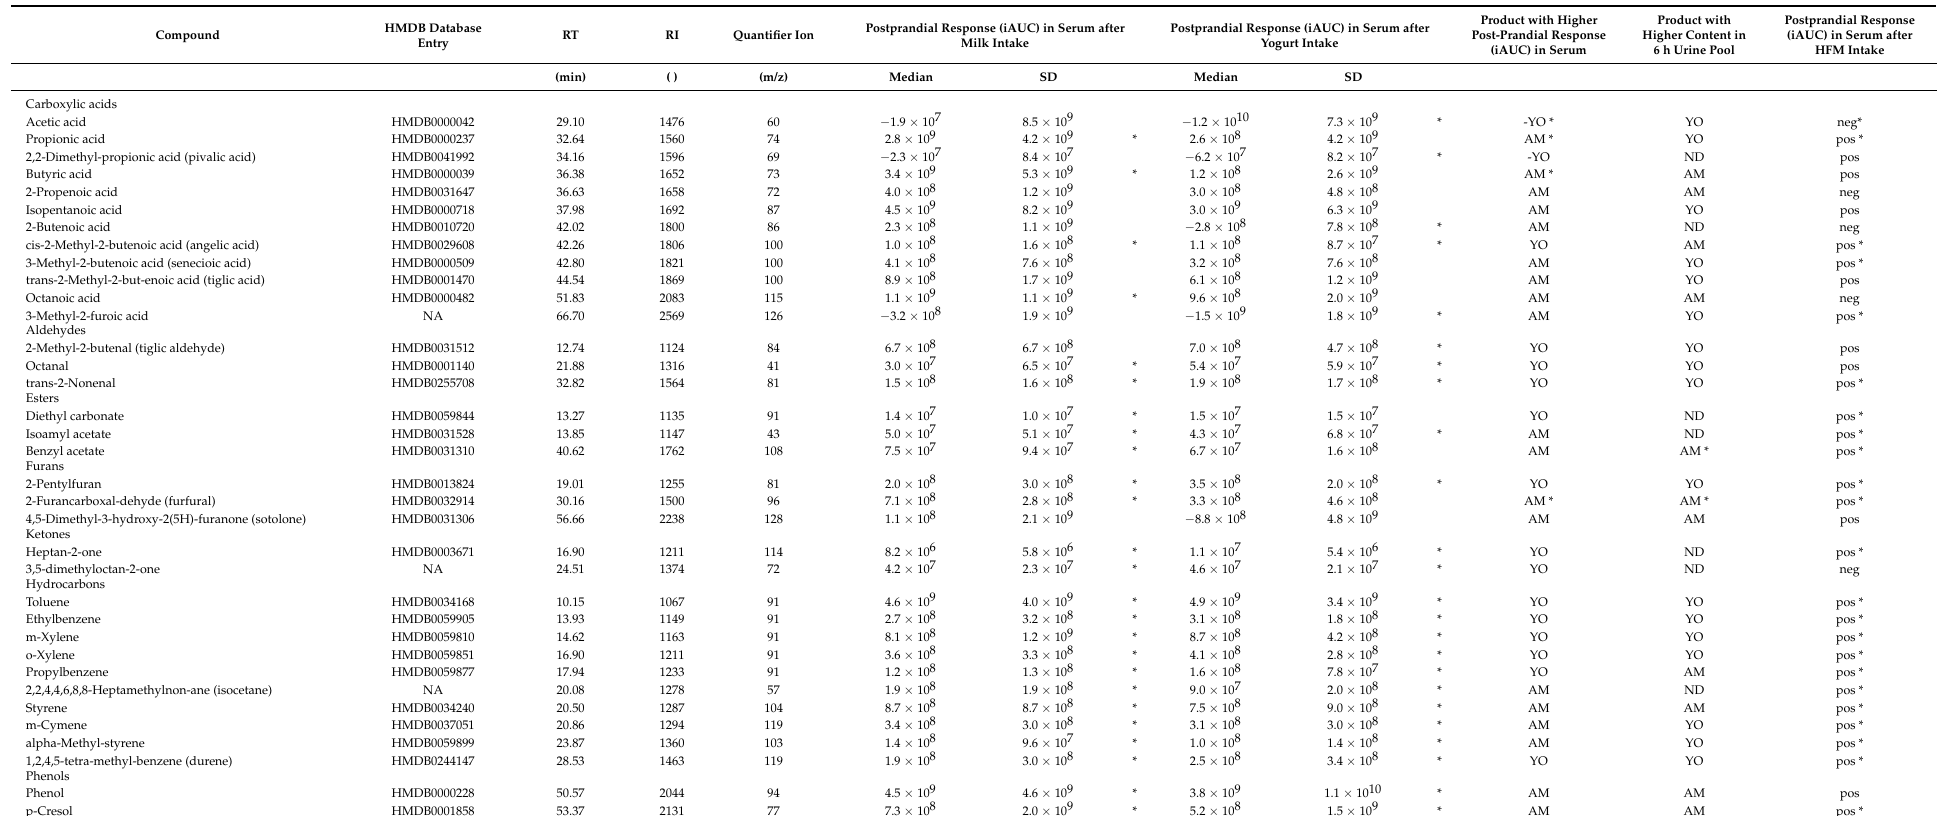
Table 2. Characteristics of postprandial active metabolites derived from the volatilomics analysis after the intake of milk (AM), yogurt (YO), and high-fat meal (HFM) by healthy